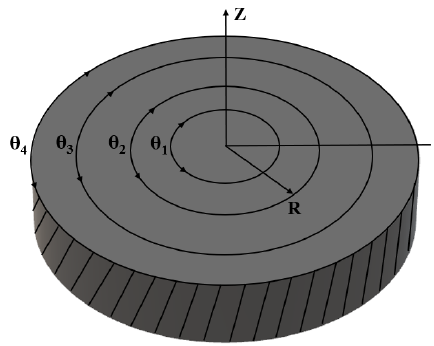
Figure 3. Figure 3. Nomenclature.